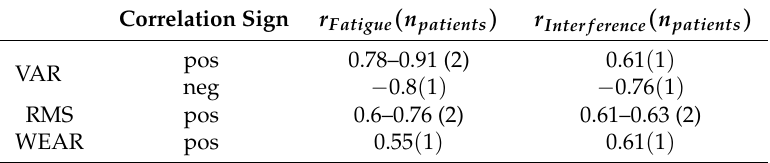
Table 7. Result of correlation analysis: the discovered correlations per patient are reported according to the sign of the Pearson’s correlation coefficient r together with the number of patients n patients in which these correlations were